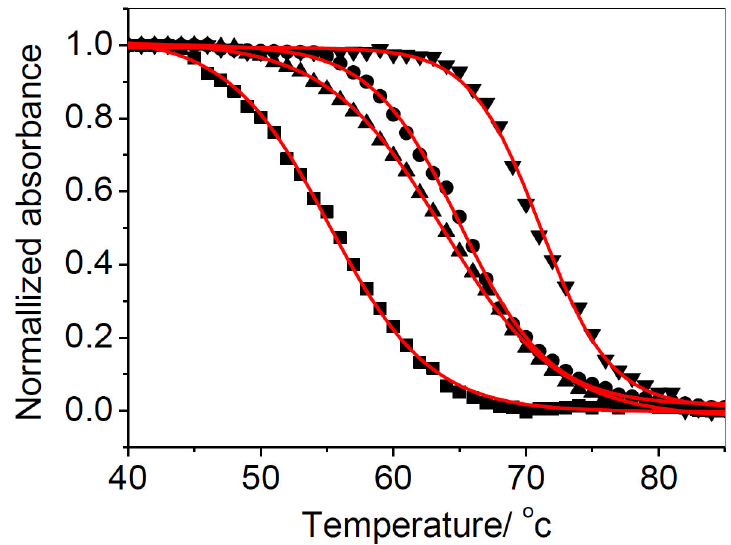
Figure 4. Melting of the G-quadruplex assessed by UV absorbance at 295 nm. Normalized UV melting curves for 10 µM G- quadruplex (■), 10 µM G-quadruplex + 10 µM [(dmb) Na HPO , 1mM Na EDTA; 10 µM G-quadruplex (▼) 10 µM G-quadruplex + 10 µM [(dmb) 2 4 2